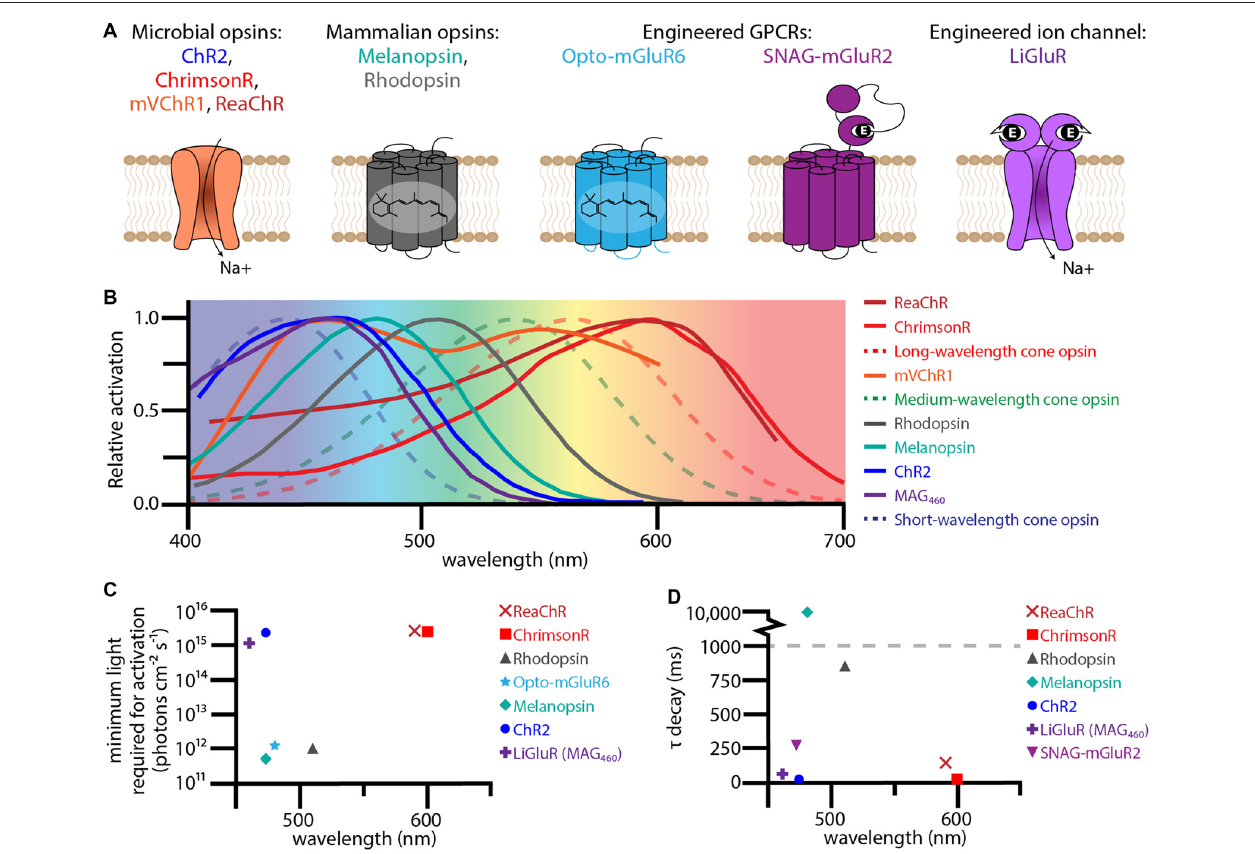
FIGURE 2 | Therapeutic optogenetic effectors used to restore the visual response in degenerate retinas. (A) Structural diagrams of optogenetic microbial opsins, mammalian opsins, and engineered GPCRs and ion-channels. The microbial opsins are all sodium permeable ion channels. The mammalian opsins, melanopsin and rhodopsin, are GPCRs with six transmembrane domains containing the chromophore 11-cis retinal. The engineered GPCR Opto-metabotropic glutamate receptor 6 (mGluR6) is comprised of the transmembrane domains from melanopsin with the intracellular loops from mGluR6. SNAG-mGluR2 is mGluR2 with a N-terminal SNAP-tag that tethers the PORTL BGAG. Upon light stimulation, the azobenzene in BGAG isomerizes allowing the distal glutamate to bind to the active site of mGluR2. The engineered ion channel LiGluR is iGluR6 with a cysteine mutation that allows for the covalent binding of the photoswitch maleimide-azobenzene- glutamate (MAG). Light isomerizes the azobenzene in MAG forcing the glutamate into the binding pocket. (B) Excitation spectra for optogenetic effectors used for vision rescue (solid lines) and human cone opsins (dotted lines). (C) The minimum light required for activation for various optogenetic effectors when used for vision rescue plotted against wavelength. (D) The τ decay constant plotted against wavelength for various optogenetic effectors. The excitation spectra, minimum light requirements, and τ decay constants were collected from the following publications: Lin et al. (2008, 2009); Gaub et al. (2014, 2015); Tomita et al. (2014); van Wyk et al. (2015); Pruneau et al. (2016); Sengupta et al. (2016); Berry et al.